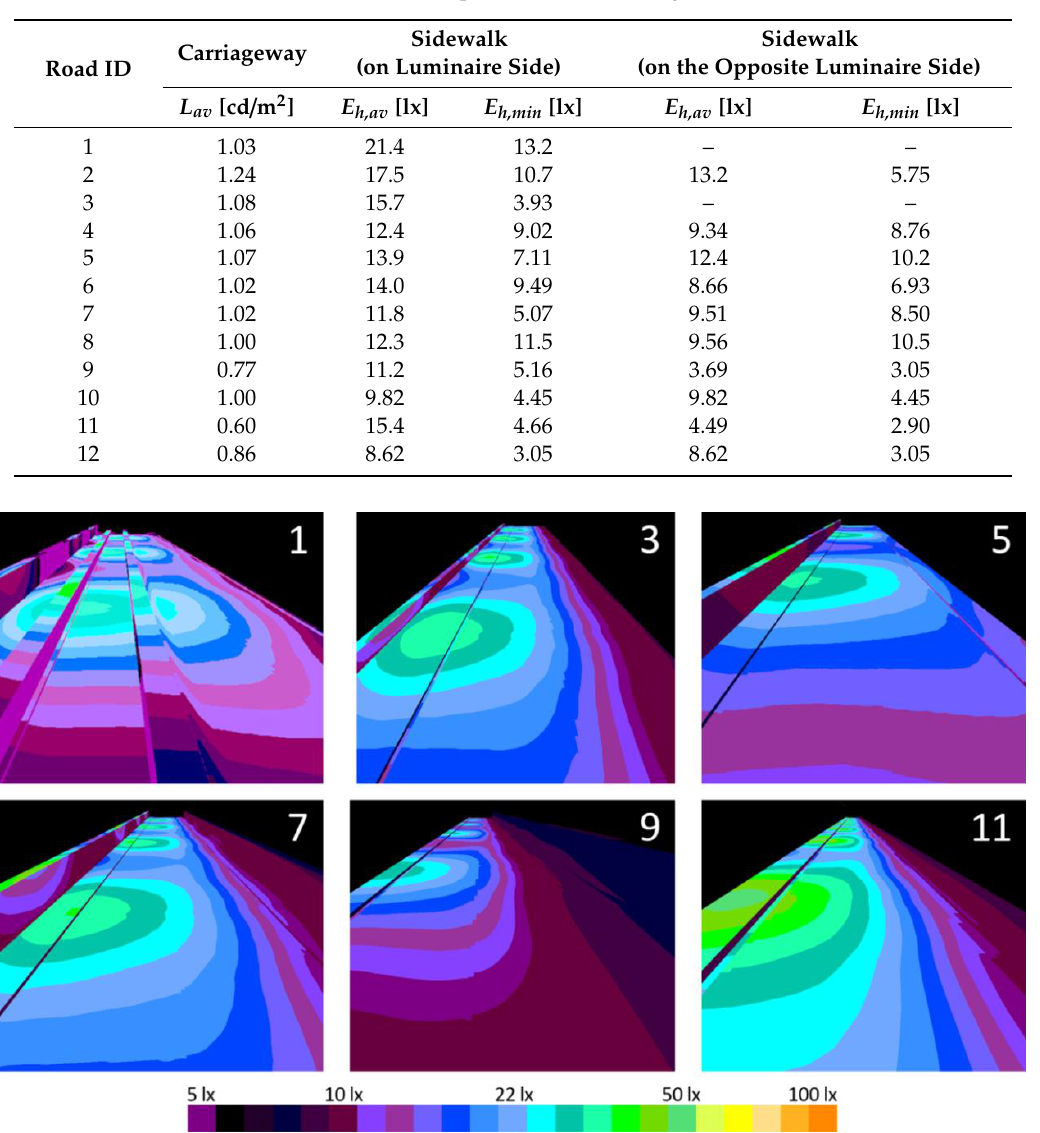
Figure 11. False-colour renderings of the horizontal illuminance mapping for some analysed roads at the design status (one for each group of Table